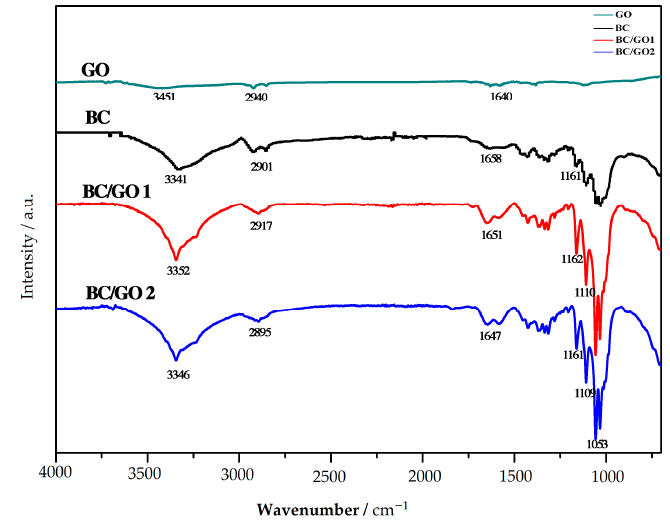
Figure 2. FTIR spectra of GO, BC, BC/GO 1 and BC/GO 2.